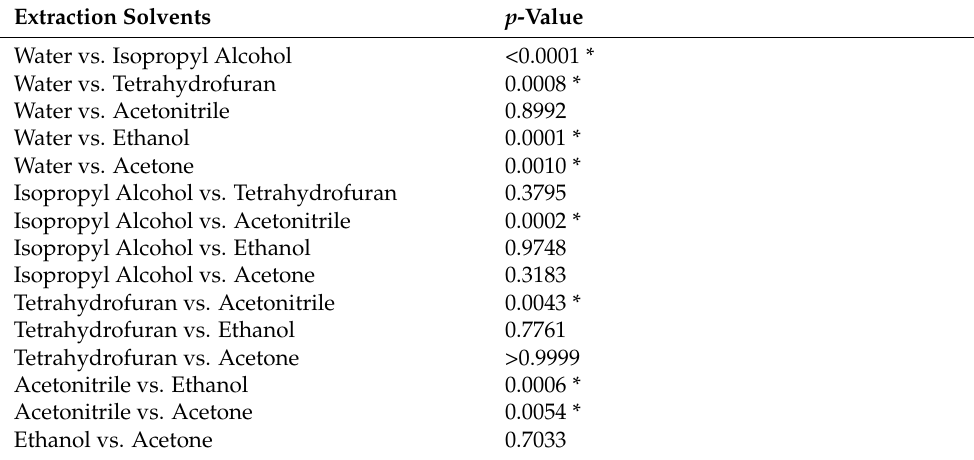
Table 3. Tukey’s Multiple Comparisons Test.